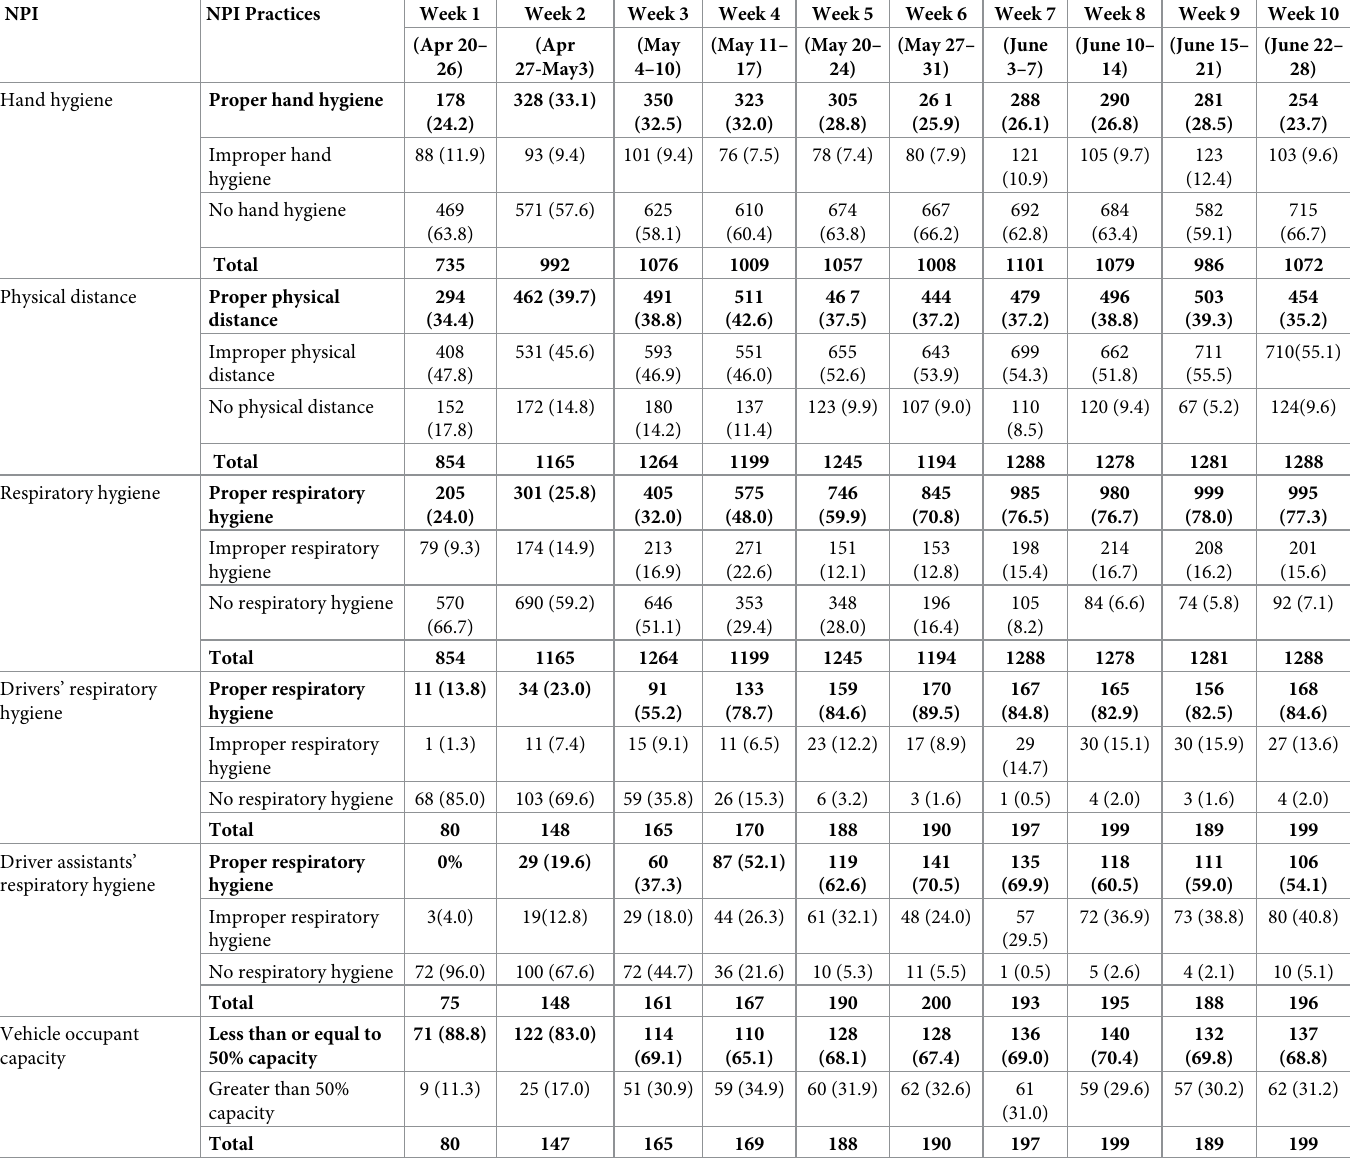
Table 2. Weekly pattern of a community practice of non-pharmaceutical interventions (Addis Ababa,